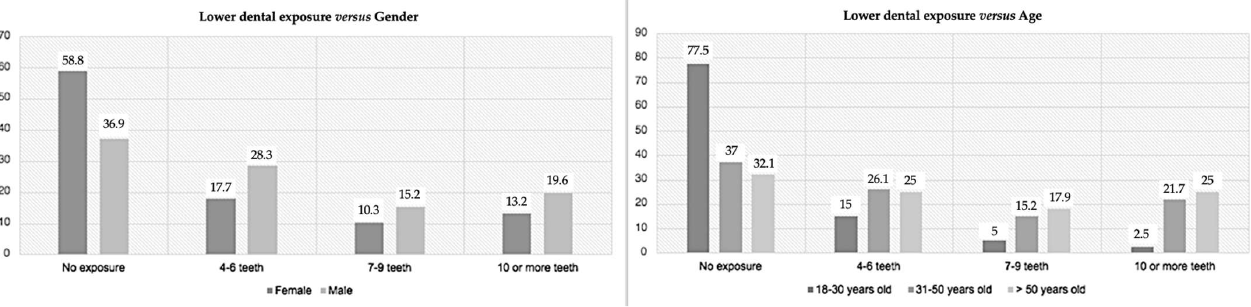
Figure 5. Prevalence of the upper teeth exposure according to gender ( left ) and age ( right ).